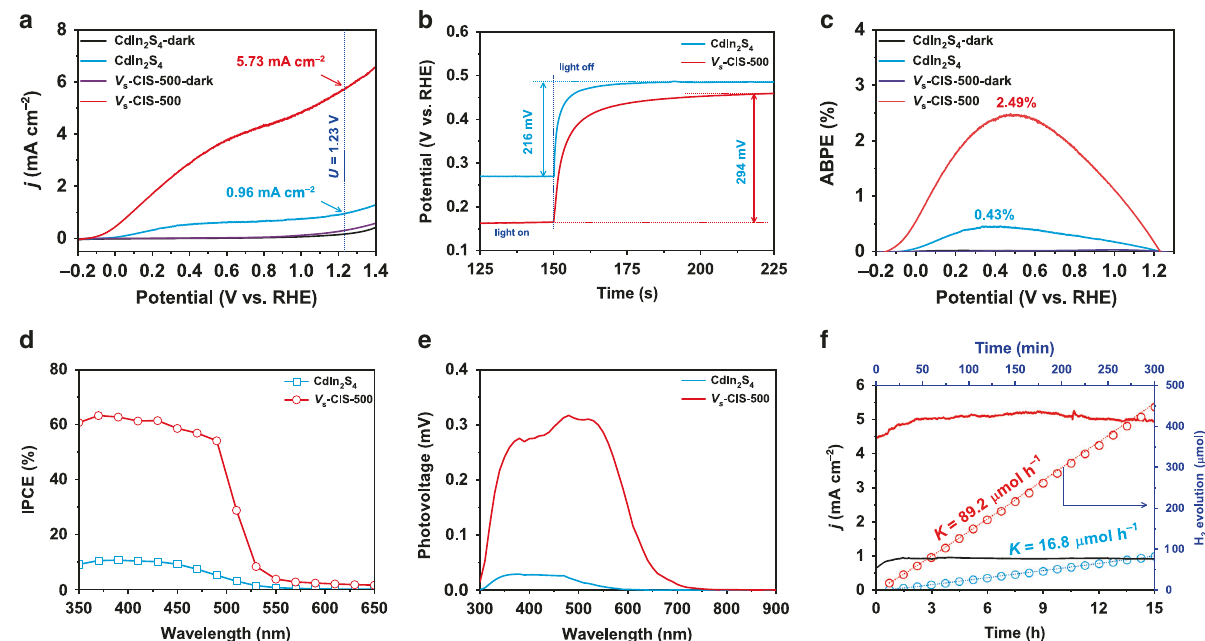
Fig. 2 Photoelectrochemical performance. a Current – voltage ( J – V ) plots measured in 0.35 M Na 2 SO 3 and 0.25 M Na 2 S mixed solution (pH = 12.5) under dark and AM 1.5 G, 100 mWcm − 2 illumination with a scan rate of 10 mV s − 1 . b Open-circuit voltages of CdIn 2 S 4 and V s -CIS-500 photoanodes were recorded in 0.5 M Na 2 SO 4 solution (pH = 7) in the dark and under illumination. c ABPE measured with a two-electrode cell for water splitting in 0.35 M Na 2 SO 3 and 0.25 M Na 2 S mixed solution (pH = 12.5) under dark and AM 1.5 G, 100 mW cm − 2 illumination. d IPCE measured at 0.6 V vs. RHE under monochromatic light irradiation. e SPV spectra of CdIn 2 S 4 and V s -CIS-500 nanoparticles. f Long-term stability test, as well as experimental and theoretical H 2 evolution, were measured in 0.35 M Na 2 SO 3 and 0.25 M Na 2 S mixed solution (pH = 12.5) under AM 1.5 G, 100 mW cm − 2